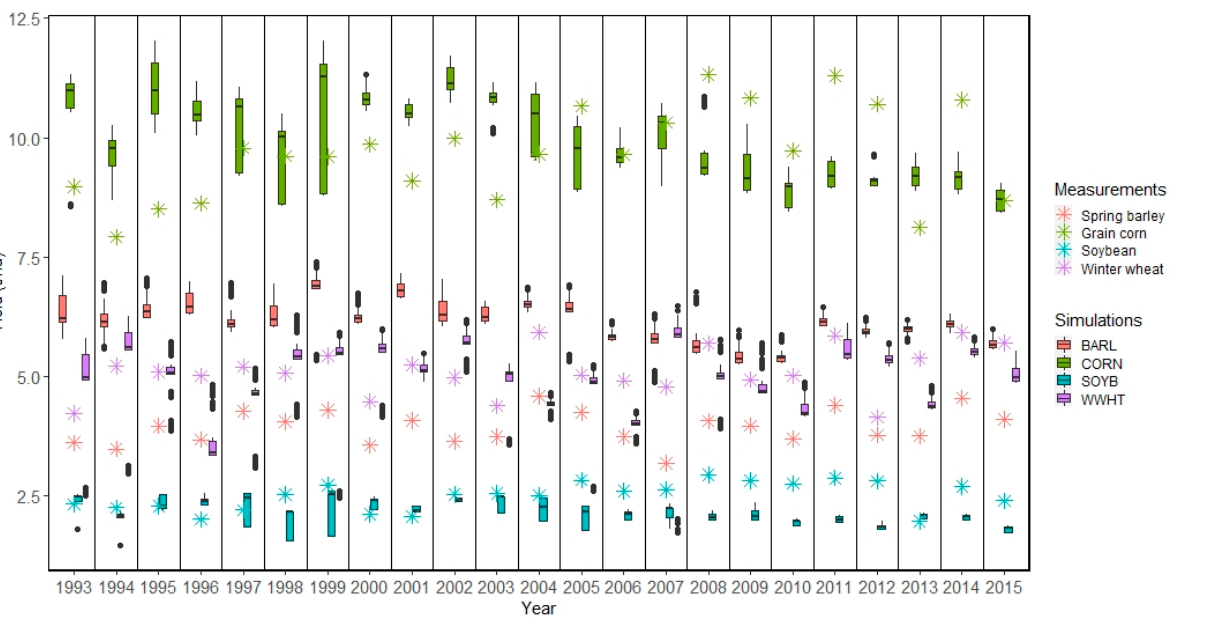
Figure 5. Measured and simulated crop yields at the HRU level in the Melk catchment for M2 setup. The SWAT simulated crops CORN (grain corn), SOYB (soybean), and WWHT (winter wheat) refer to Table S3.